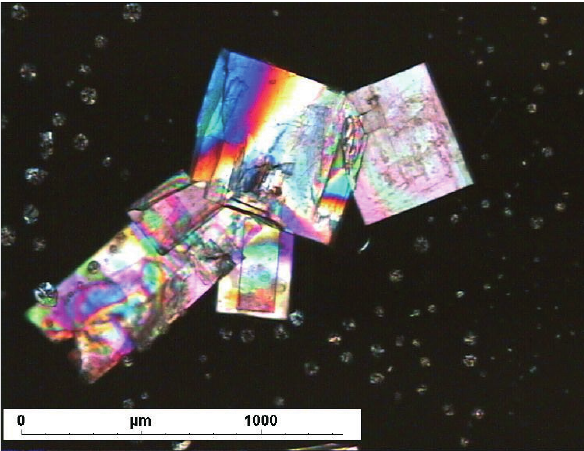
Fig. 3. – Polarized light optical microscopy photography of the 2-n- propylquinoline formulation (× 81).